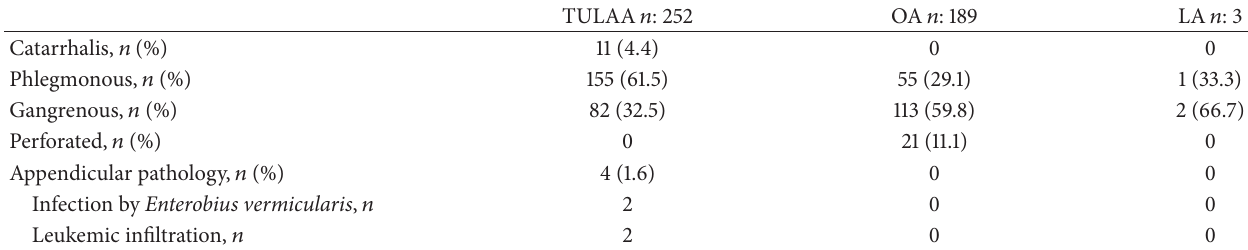
Table 1: Histopathologic examination of the all appendix stamps treated (444 children).